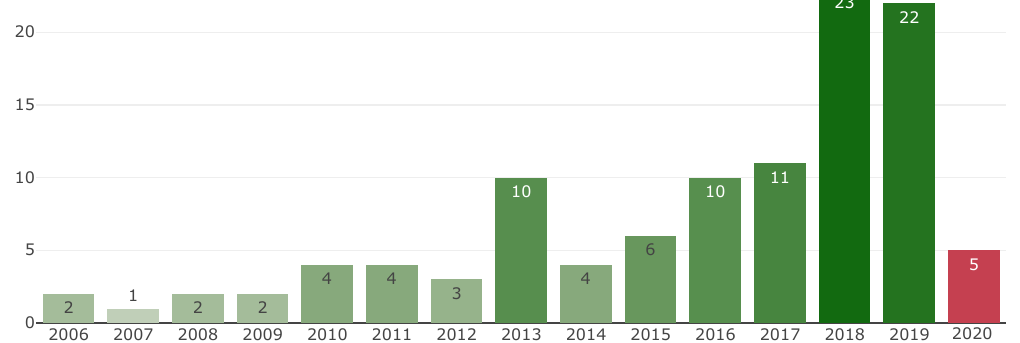
Figure 3. Number of studies published per year included in the literature